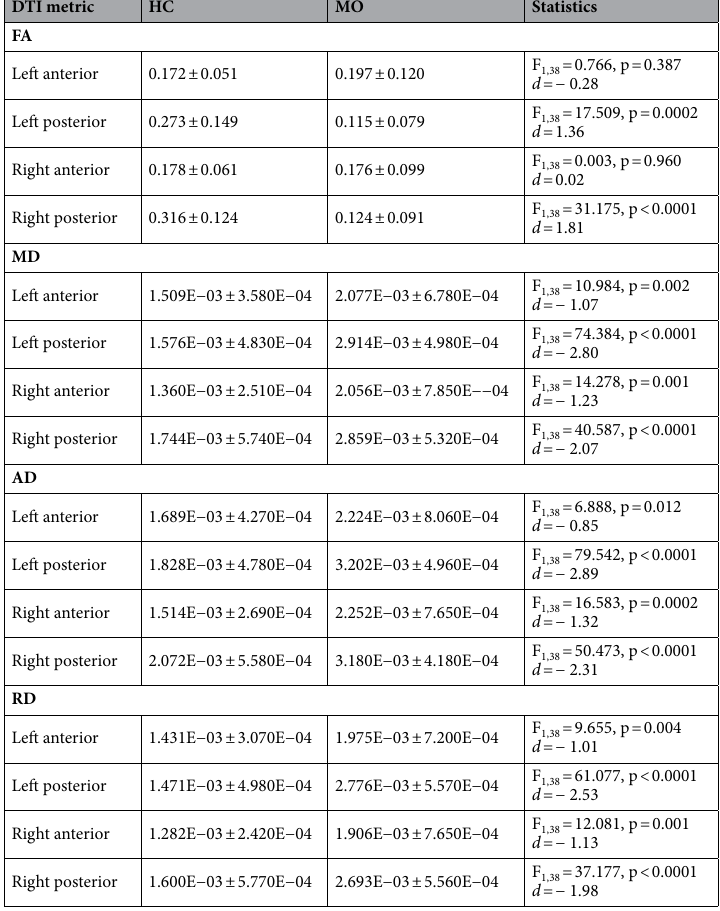
Table 3. Descriptive and univariate statistics for the fractional anisotropy (FA), mean diffusivity (MD), axial diffusivity (AD), and radial diffusivity (RD) of the anterior and posterior part of the left and right hypothalamus in HC and